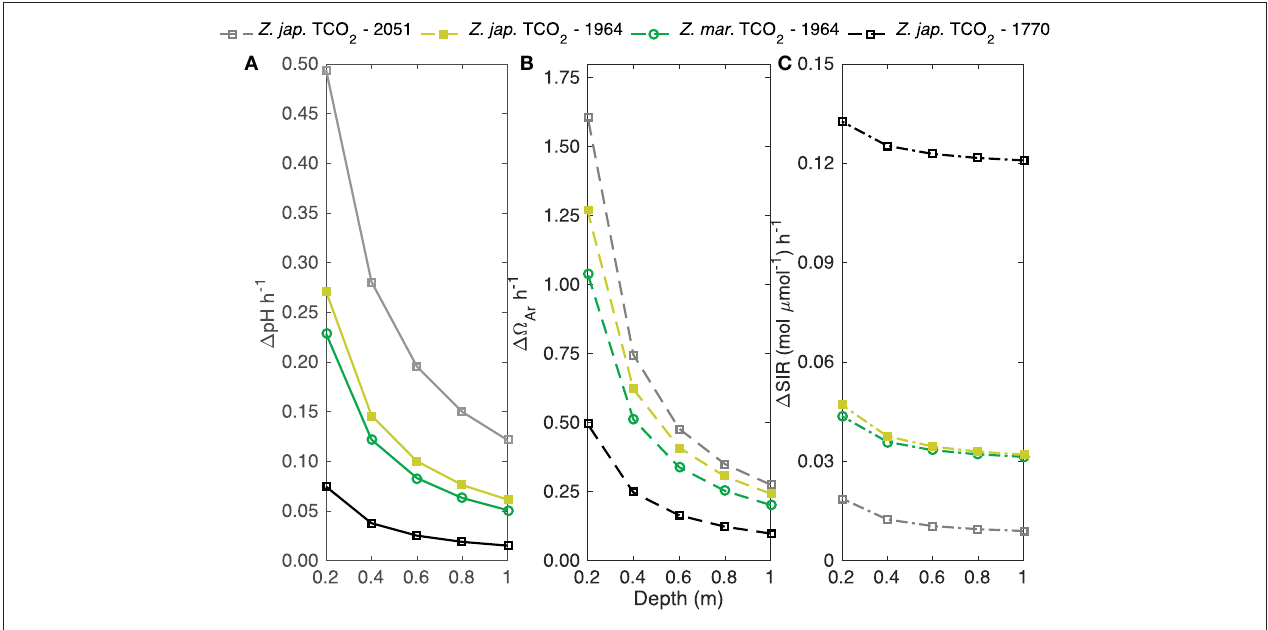
FIGURE 5 | Yellow and green lines are the predicted change in (A) pH, (B) aragonite saturation state ( (cid:127) ar ), and (C) substrate-to-inhibitor (mol µ mol − 1 ) ratio based on the predicted